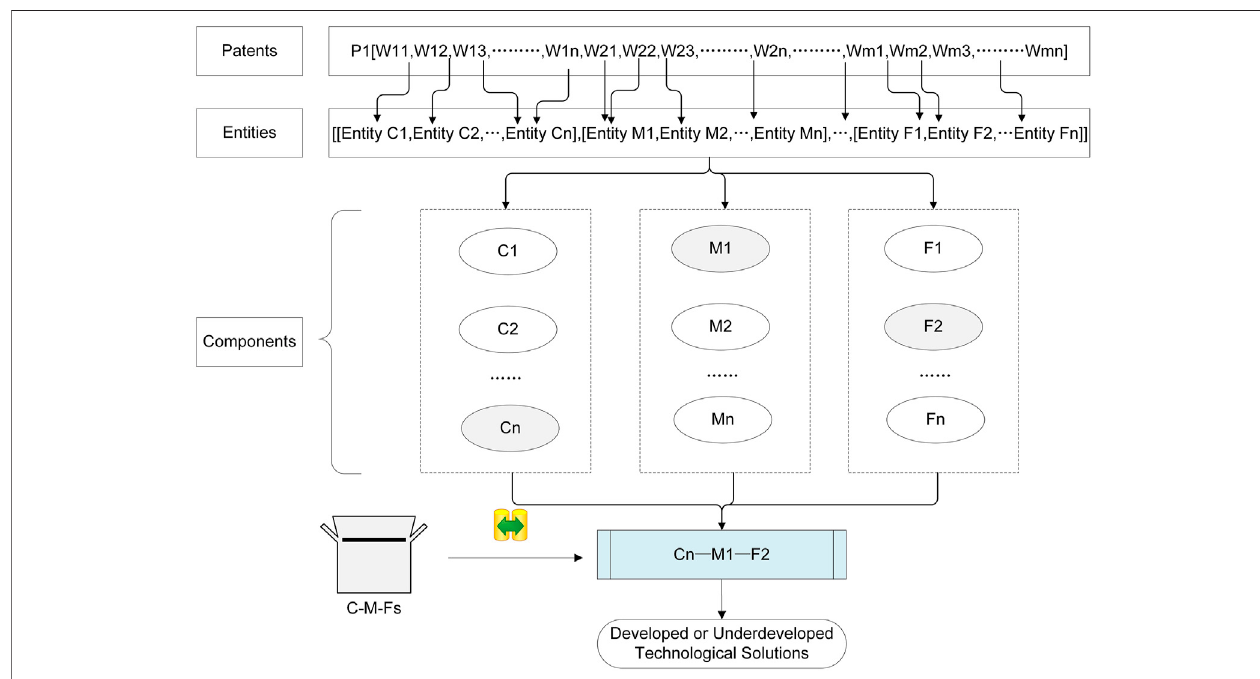
FIGURE 5 | Identifying technological solutions in patent research.